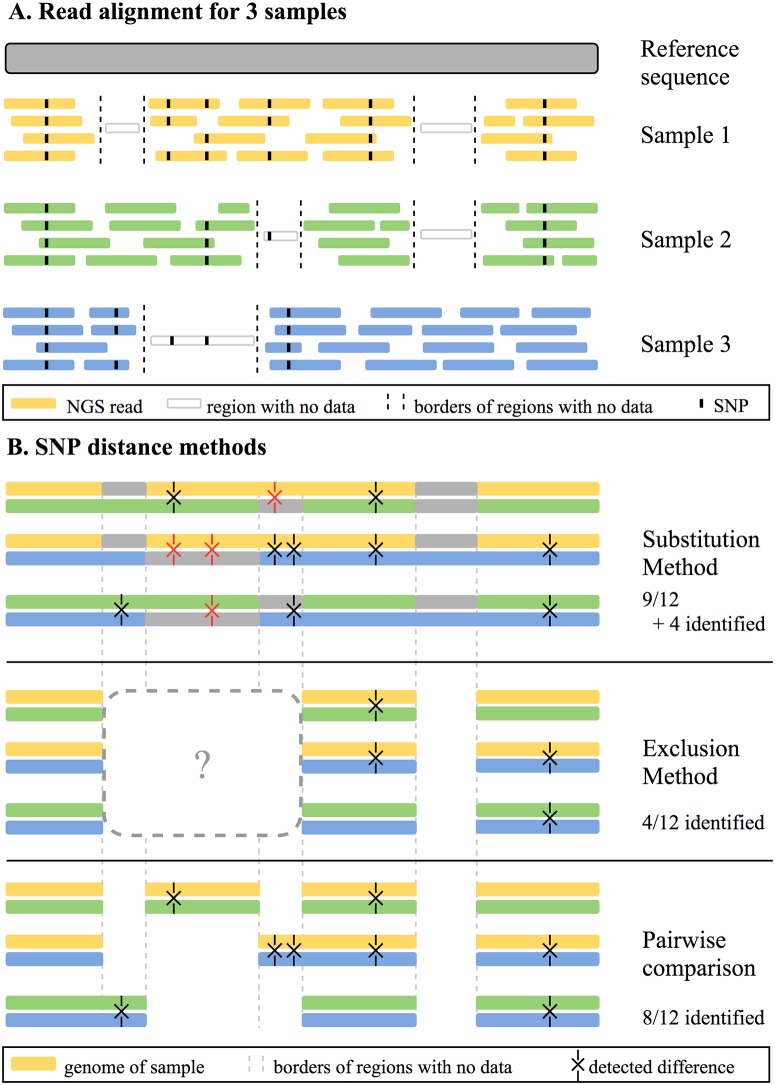
Description and comparison of three SNP distance methods.(A) Schematic representation of the next-generation sequencing (NGS) reads of three samples aligned to a reference sequence. Reference sequence is depicted in gray, while samples are colored yellow, green and blue. Dashed lines represent borders of regions of the samples that are not covered by any NGS reads. Transparent reads represent the true genome of the samples in regions with no coverage. Reads reveal single nucleotide polymorphisms (SNPs) when comparing the samples to the reference sequence (depicted as black points on the reads). SNPs also occur in sequences of samples where no read data is available, these can not be detected using any method that is based on these aligned reads. In sum, the samples have 12 differences, while only 8 can be identified with the available reads. (B) Representation of compared sequence parts using three different distance measuring methods. Each method compares pairs of samples. Samples are depicted as whole genomes in yellow, blue, and green. Differences between samples are marked with X, true differences are colored black and incorrect ones are colored red. The three methods differ in how regions with missing information in one sample are treated when comparing other samples of the dataset. With the substitution method, missing parts in the samples are replaced with the corresponding parts of the reference sequence (in gray). This leads to incorrectly identified differences, where the true sequence of the samples differs from the reference sequence but has no read coverage. Using the exclusion method, all regions with no coverage of all samples are excluded in all comparisons, e.g. low coverage in Sample 1 influences the comparison of Samples 2 and 3. This leads to overlooking differences between samples, in this example only 4 of 12 detectable differences were identified. The pairwise SNP comparison method used in PANPASCO determines all comparable regions for each pair of samples. Regions with low coverage in each pair are excluded for pairwise comparison. This way all detectable differences are identified, without introducing additional, incorrect ones.